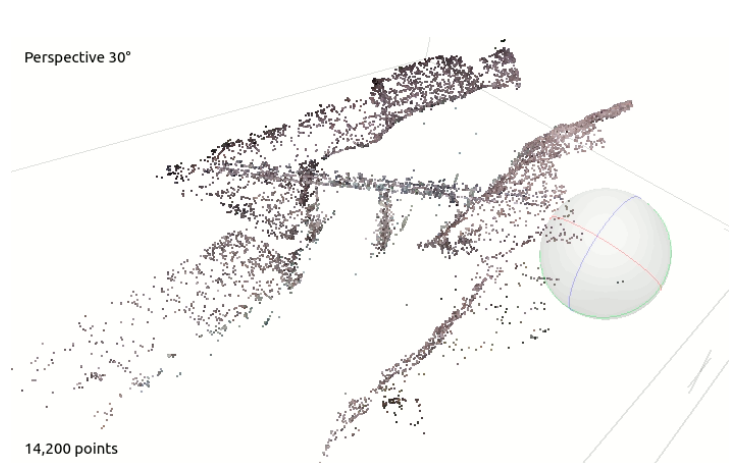
Table 1. Parameters used for point cloud computation. References can be found in the documenta- tion of the software Metashape [32].